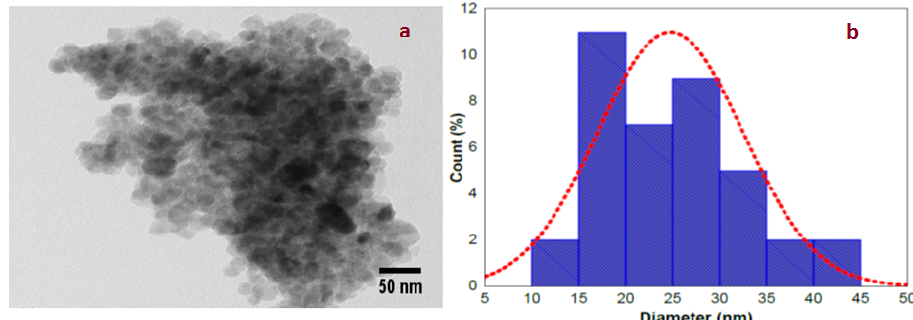
Figure 6. ( a ) TEM image of TiO 2 nanoparticles and ( b ) size distribution